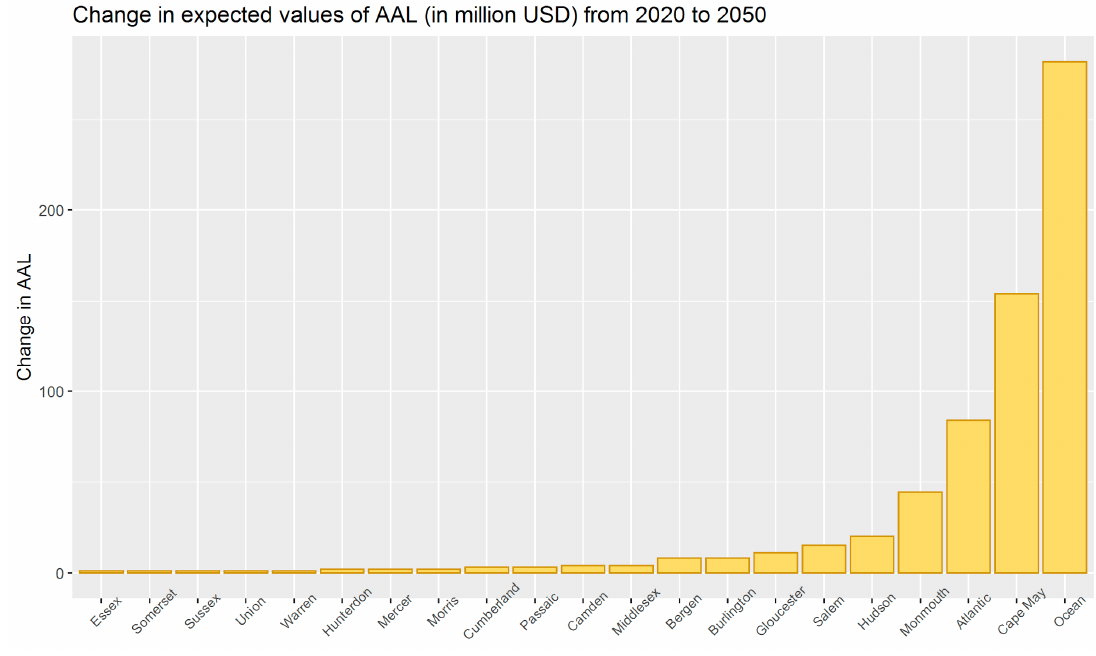
ff erent counties. Climate 2020 , 8 , x FOR PEER REVIEW